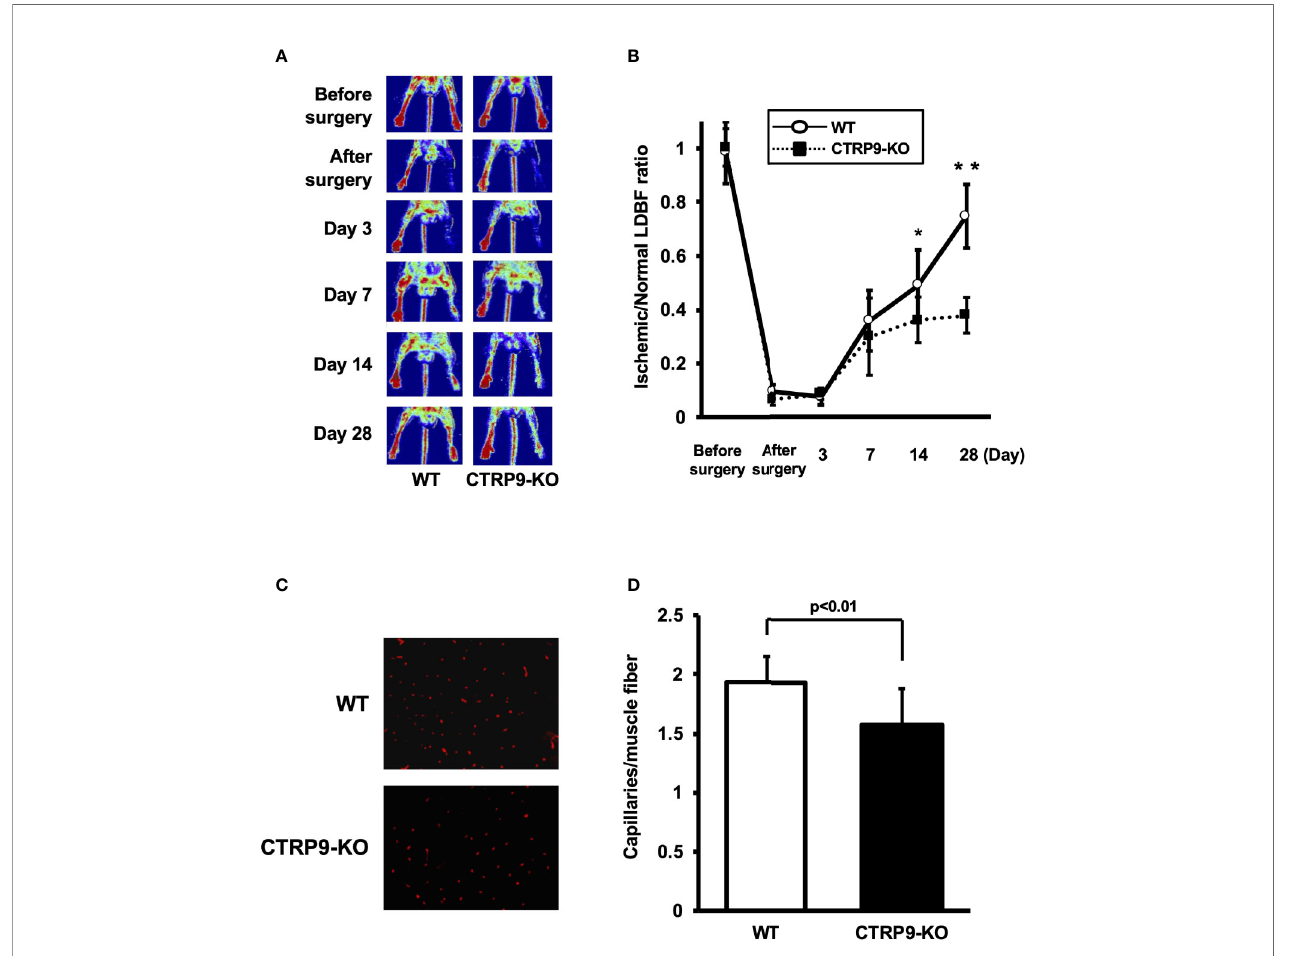
FIGURE 1 | CTRP9-KO mice show reduction of perfusion recovery and capillary density in ischemic limbs. (A) Representative laser Doppler blood fl ow (LDBF) images in ischemic limb of CTRP9-KO or WT mice. A low perfusion signal (dark blue) was observed in the ischemic hindlimb of CTRP9-KO mice, whereas a high perfusion signal (red) was detected in WT mice at postoperative days 14 and 28. (B) Quantitative analysis of the ischemic to nonischemic LDBF ratio in the WT and CTRP9-KO mice before surgery and at different time points after surgery. Results are shown as the mean ± SD (n = 7-8 mice for each group). * p < .05, ** p < .01 vs CTRP9-KO mice. (C) Fluorescence staining of ischemic tissues with anti-CD31 monoclonal antibody (red) at postoperative day 28. (D) Quantitative analysis of capillary density in WT and CTRP9-KO mice on postoperative day 28. Capillary density was expressed as the number of capillaries per muscle fi ber. Results are presented as mean ± SD (n = 3 mice for each